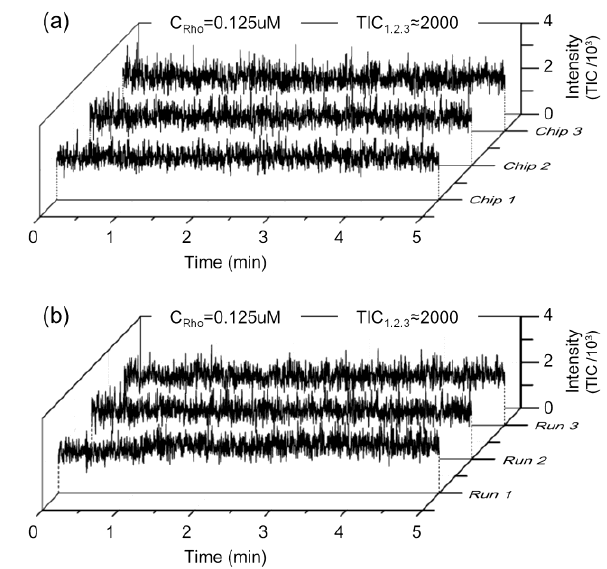
Figure 8. Reproducibility of chip-to-chip and run-to-run tests. ( a ) The mean ion counts of Rhodamine B were 1969.90, 2137.60 and 2055.85 for chips 1 to 3, respectively when the solution concentration was 0.125 μM; ( b ) the mean ion counts were also approximately 2000 for run 1 to 3 of chip 2. The solution concentration was 0.125